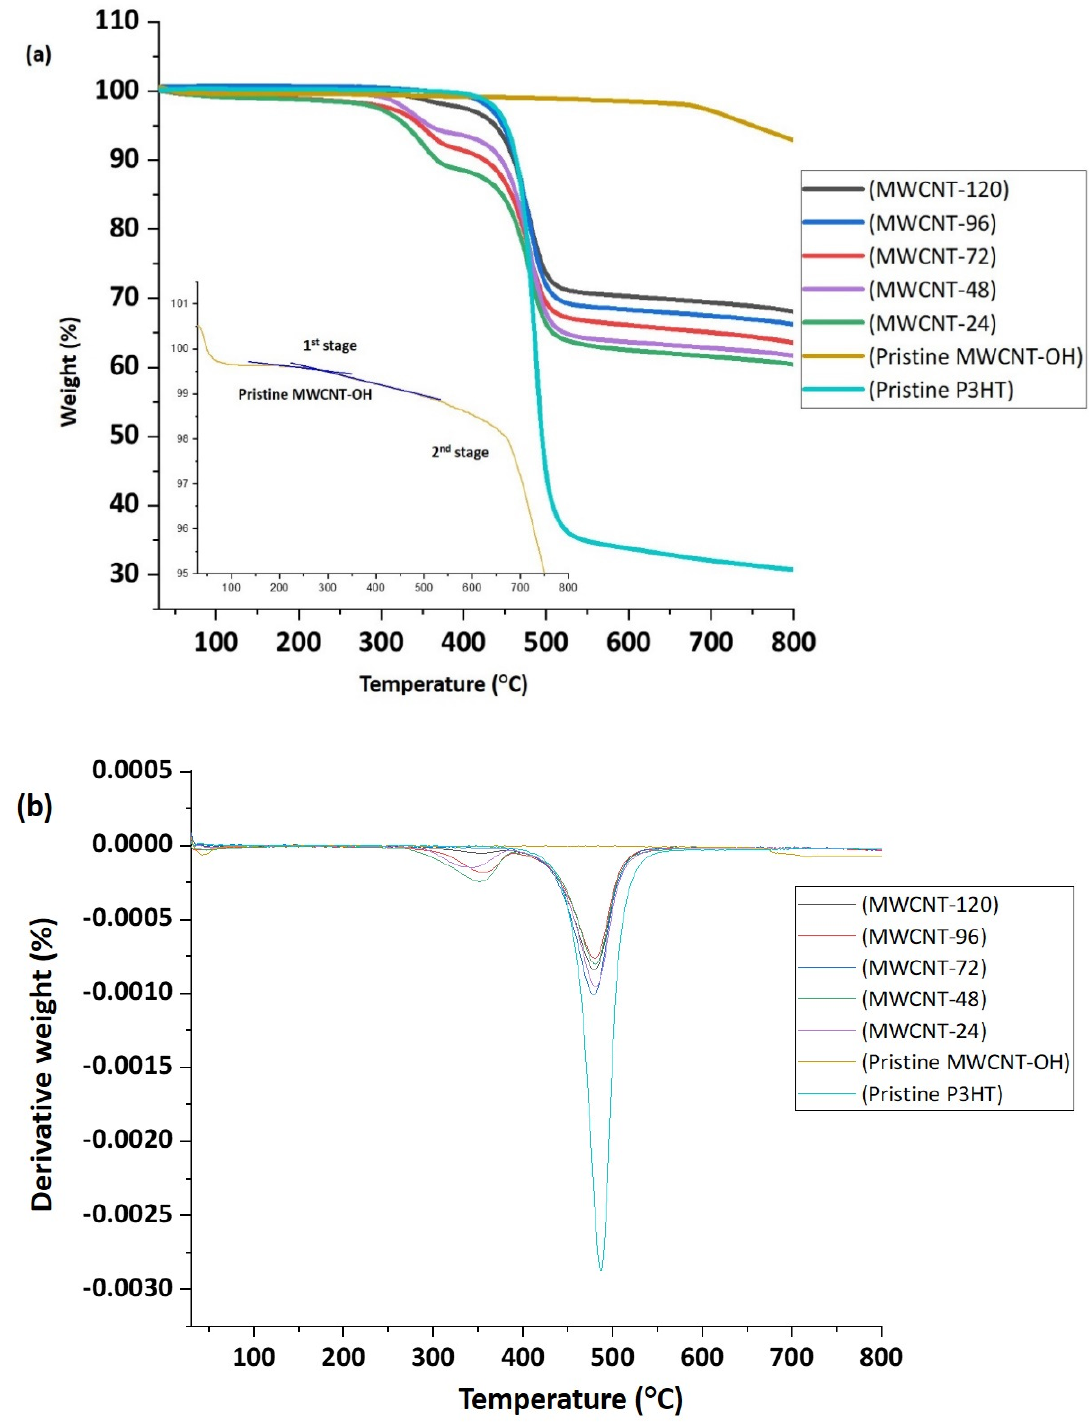
Figure 7. ( a ) TGA ( b ) DTG curves for pristine P3HT, pristine MWCNT-OH, and P3HT/MWCNT-OH nanocomposites at different reaction times.